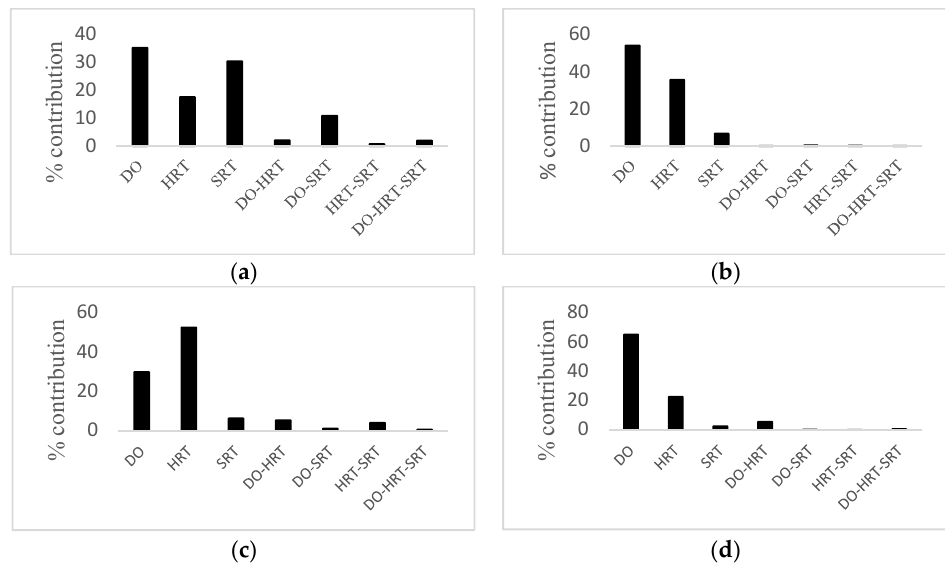
Figure 2. Percent contribution of each factor on the performance statistics of ( a ) CBZ removal, ( b ) COD removal, ( c ) ammonia removal, ( d ) phosphorus removal.